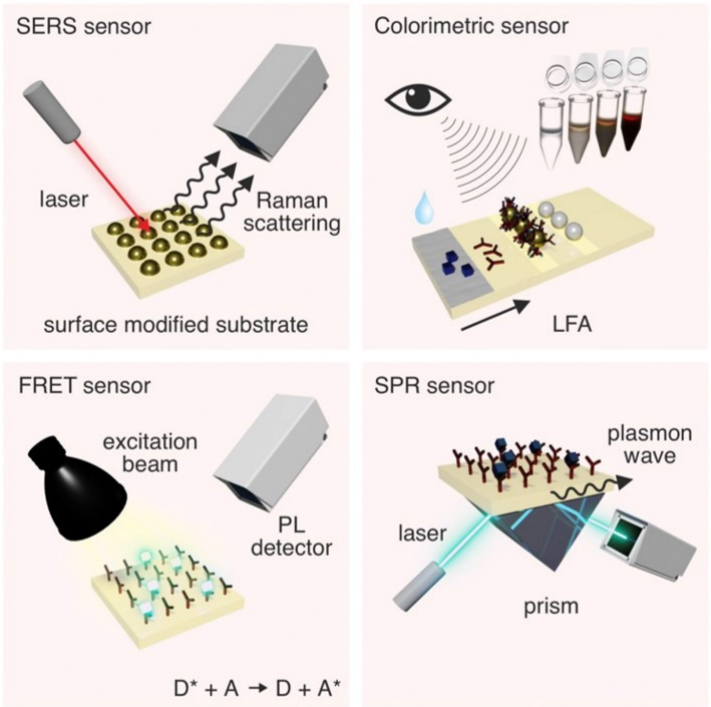
Figure 10. Overview of graphene-based optical sensors. Reprinted with permission from Ref. [133]. Copyright 2020, Elsevier. The * represents the energy transferred from the donor fluorescent protein to the acceptor fluorescent protein.